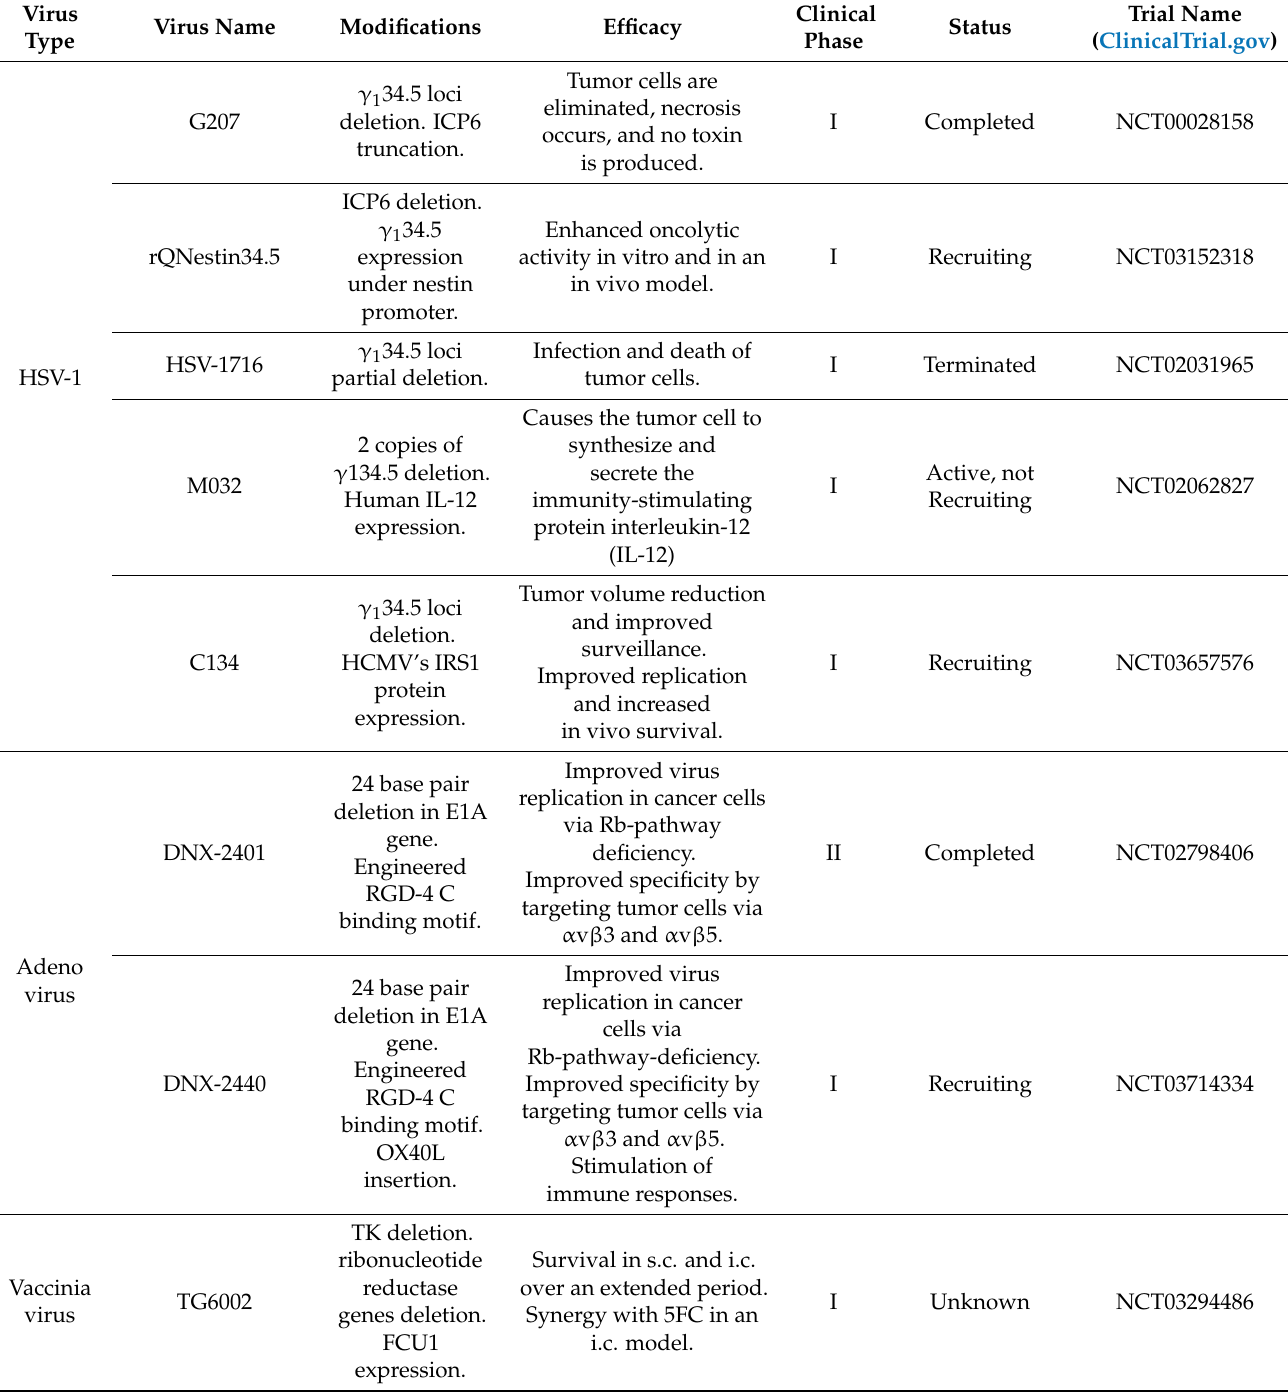
Table 1. DNA and RNA viruses proposed as Glioma oncolytic agents in clinical